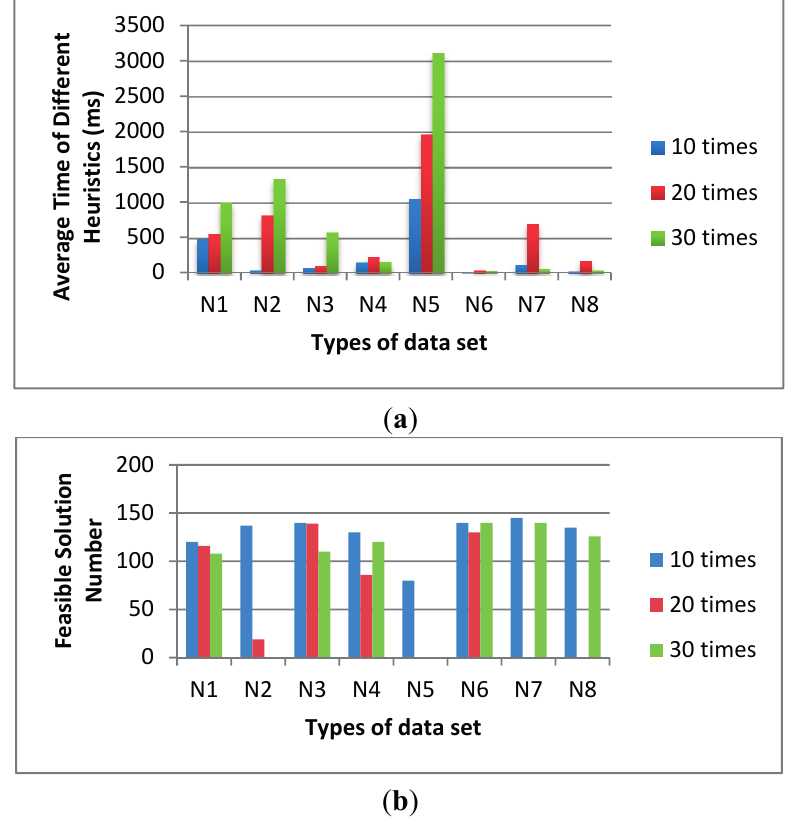
Figure 4. The influence of sub-population iterations on ( a ) average time and ( b ) feasible solution